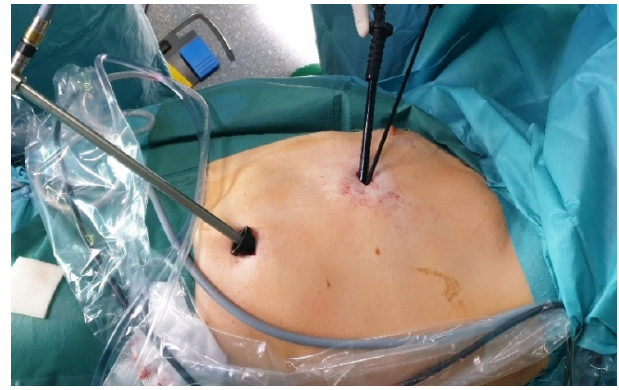
Figure 2. Trocar positioning for 2P-VATS.